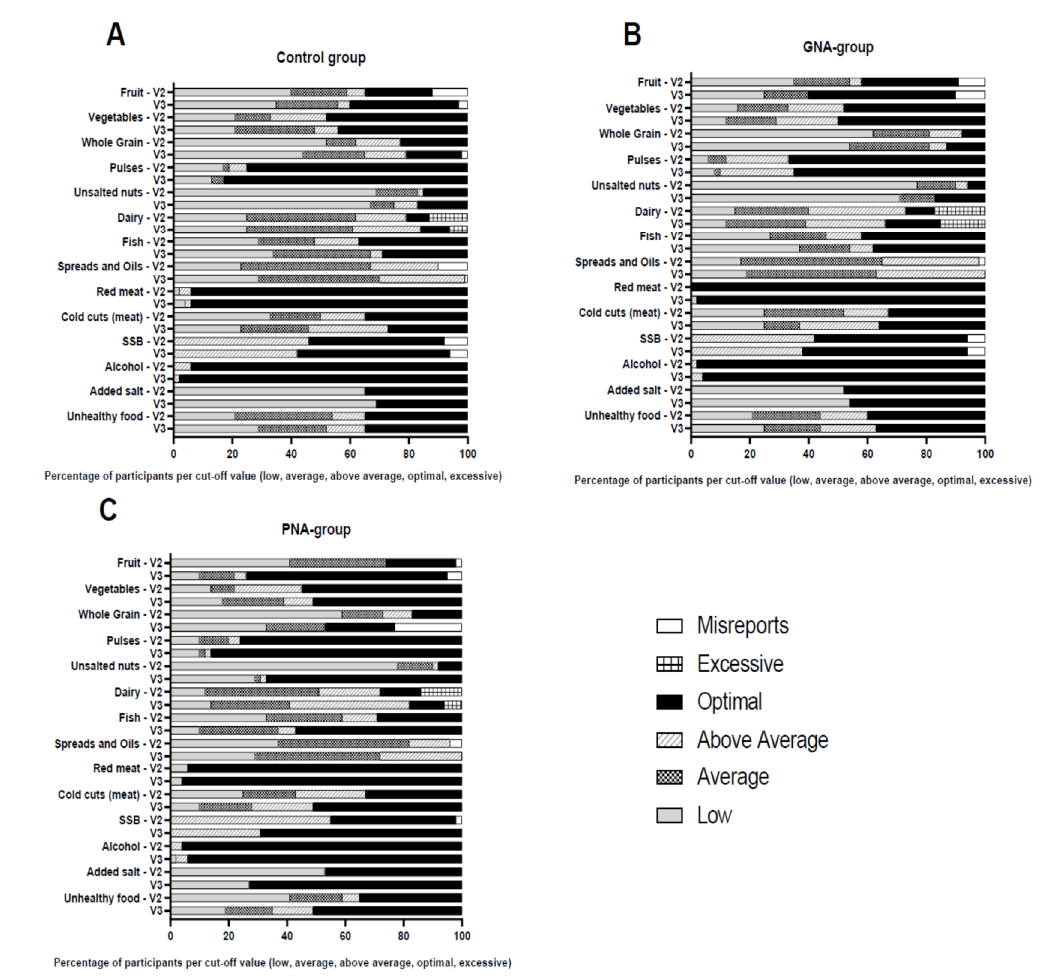
Figure 3. Nutrition intake status (NIS) before (V2) and after the nine-week (V3) intervention period in participants receiving ( A ) no nutrition advice (control); ( B ) GNA; ( C ) PNA. Data are percentages of participants in the control; GNA and PNA groups have a low, average, above average, optimal or excessive NIS of the 14 food categories. In white the percentage of misreports are indicated.